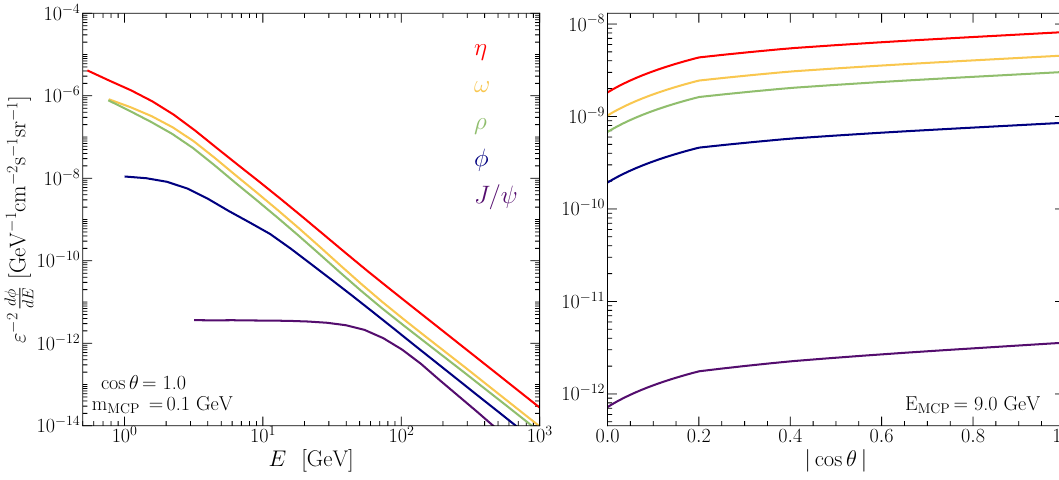
Figure 2 . Surface flux of millicharged particles from different parent mesons. Left: spectra, which scales as ε 2 , of millicharged particles arriving at the surface (i.e., before any potential attenuation/deflection) of the Earth with zenith angle 0 ◦ , for each one of the different parent mesons. Right: angular dependence of the flux at 9 GeV. In both panels the MCP mass is set to 100 MeV. of these features remains unclear, and it is an active research topic (see, for instance, refs. [62,